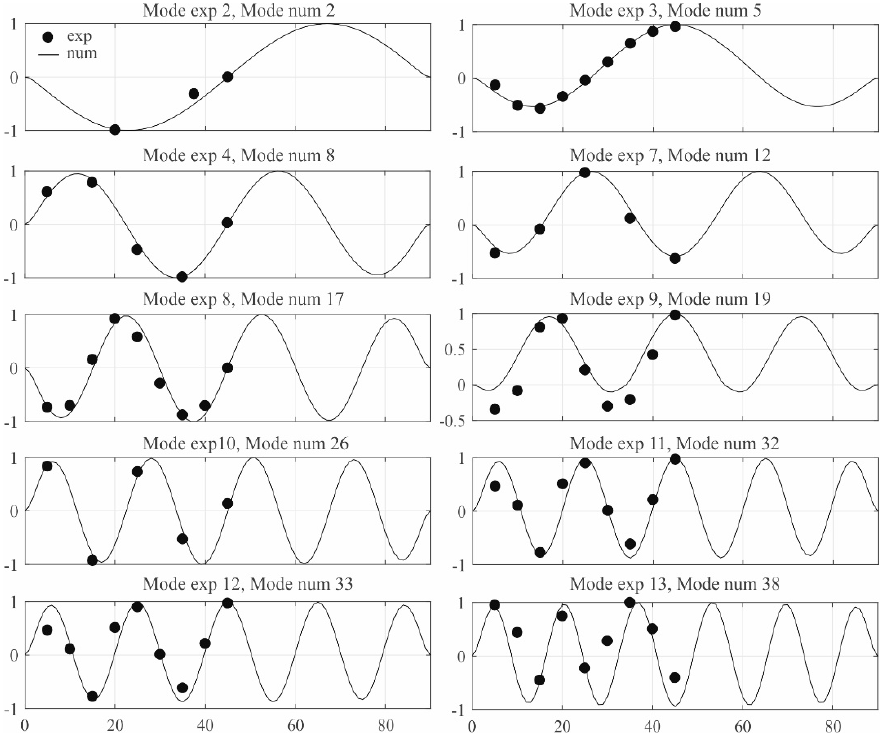
Figure 13. Comparison between experimental and numerical mode shapes.